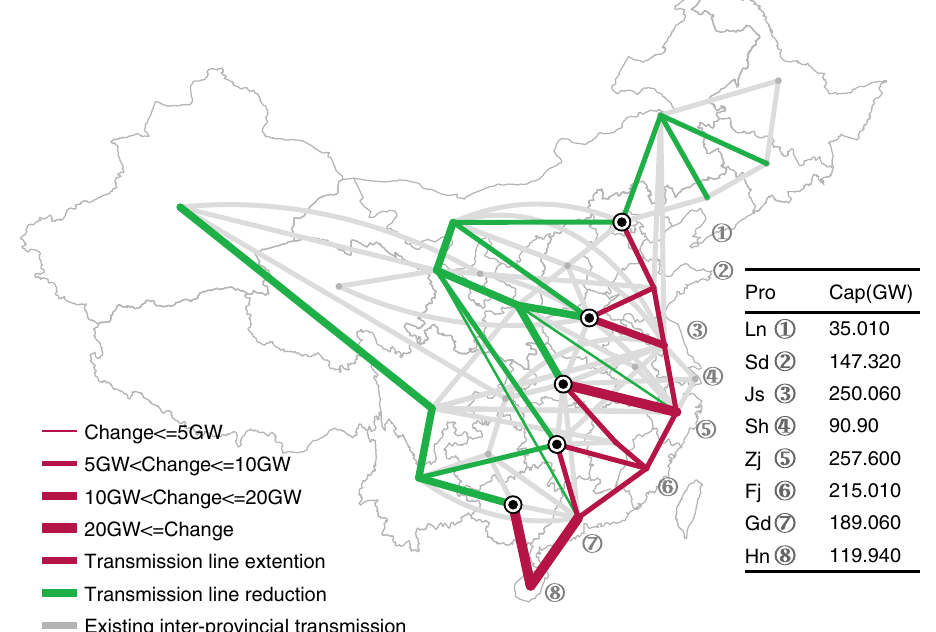
Fig. 6 | Optimal geographical distribution of UHV transmission investments and offshore wind deployments in mainland China. Capacity variation of transmission network expansion between S1 (limited level of offshore wind according to prier roadmap study), and S3 (freely optimization of offshore wind).